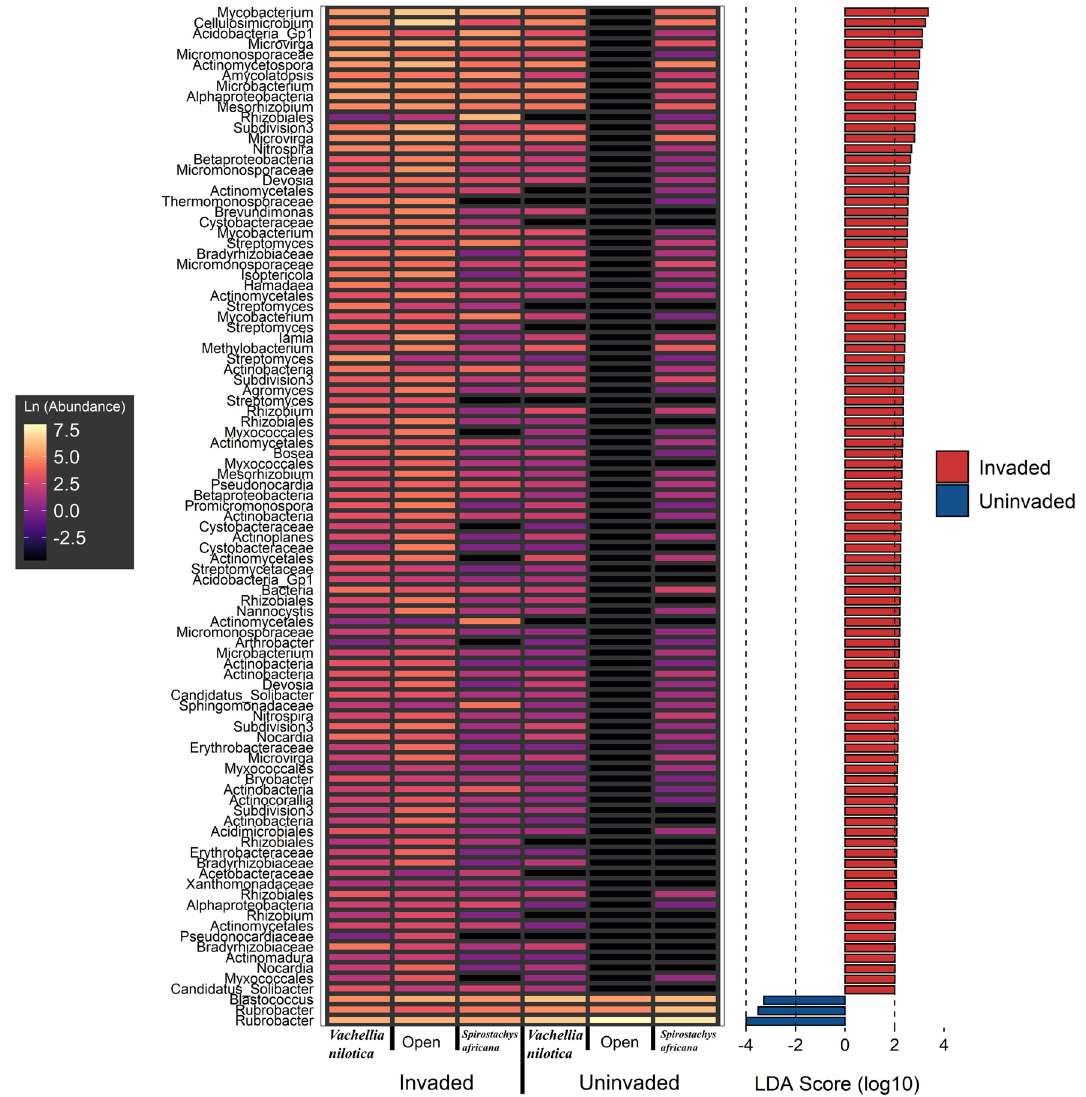
Figure 4. Bacterial taxa that are significantly differentially abundant between status (invaded, uninvaded) and tree cover ( V. nilotica , S. africana , none). Shown on the left is a heatmap of the taxa with Ln(Abundance) values, and on the right the LEfSe LDA scores for each taxon 88 . Only significant LDA scores are shown. The red and blue colours associated with the LDA scores indicate to which categories the taxa were associated with. Note that a small constant (0.01) was added to heatmap abundance values to avoid the undefined natural logarithm of 0.